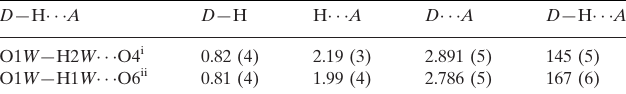
Data collection Bruker APEXII area-detector diffractometer Absorption correction: multi-scan ( SADABS ; Sheldrick, 1996) T min = 0.285, T max = 0.344 Refinement 320 parameters 158 restraints